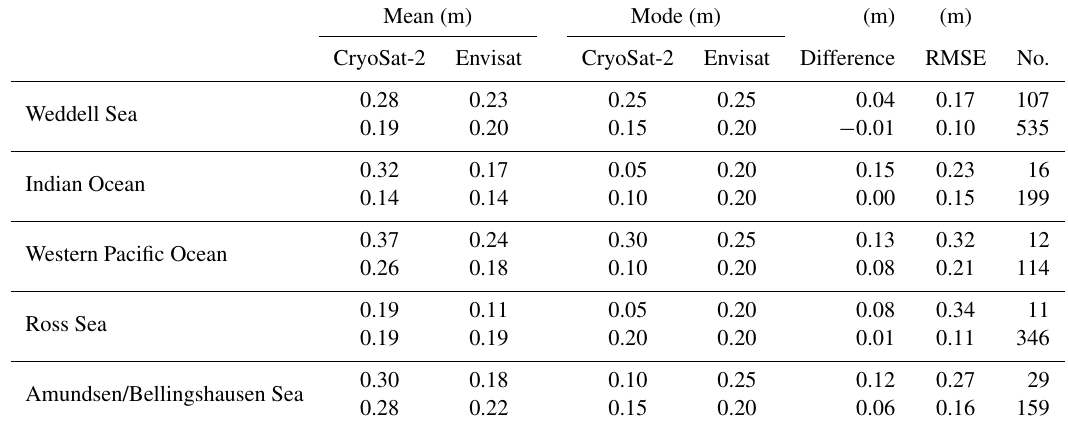
Table 3. Modal and mean freeboard, the differences between CS-2 and Envisat as well as root-mean-square error for averages in the individual sectors for summer and winter. Mean